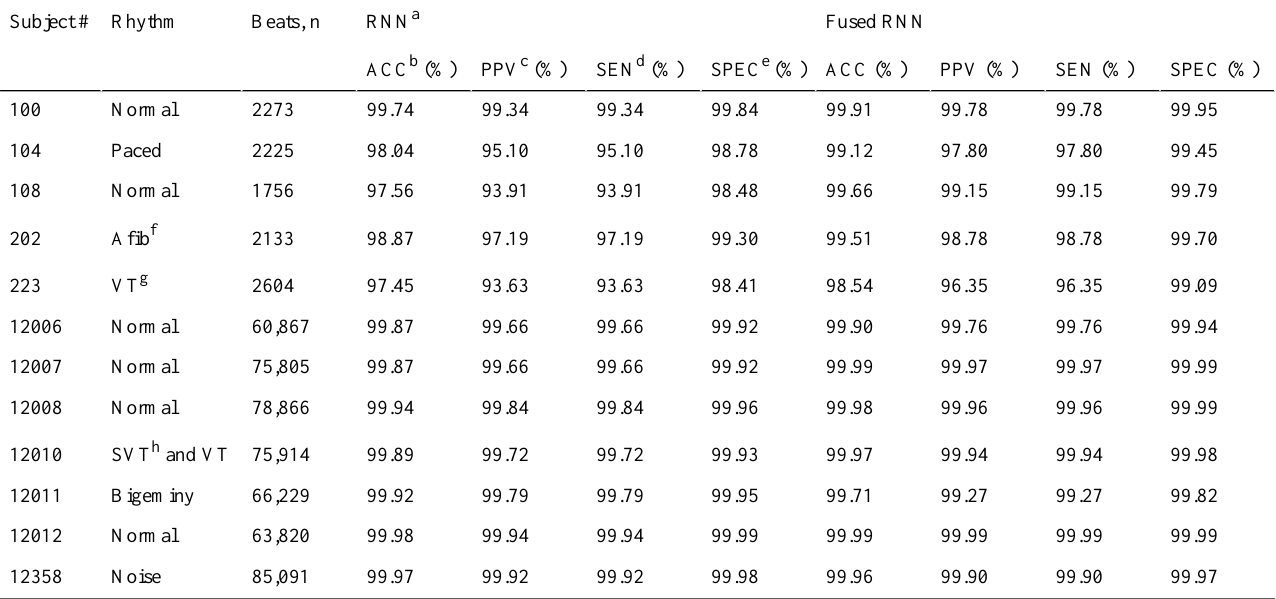
Table 5. Overall accuracies of the baseline and lightweight models according to subjects in the test set. (Subject numbers 100 to 223 are from MIT-BIH, and the rest are from